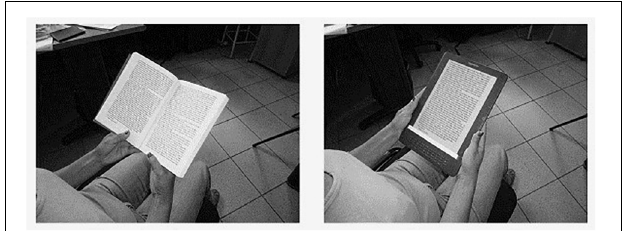
FIGURE 1 | The print pocket book and the Kindle. The left-hand page in the print book corresponds to the page displayed on the Kindle.